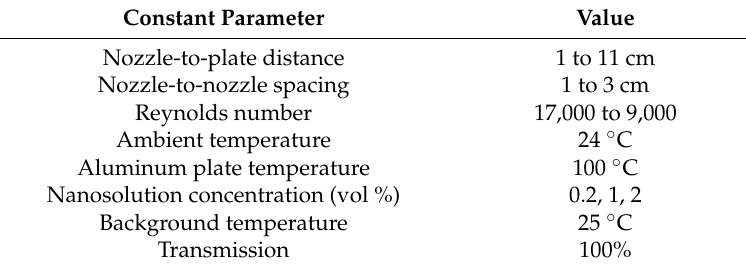
Figure 4. Twin impingement jet mechanism used in the study. Table 1. Values of the constant parameters.